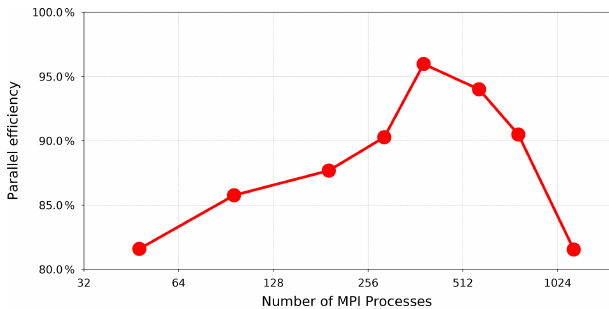
Figure 9. The parallel efficiency of ECHAM6 (using the concurrent radiation